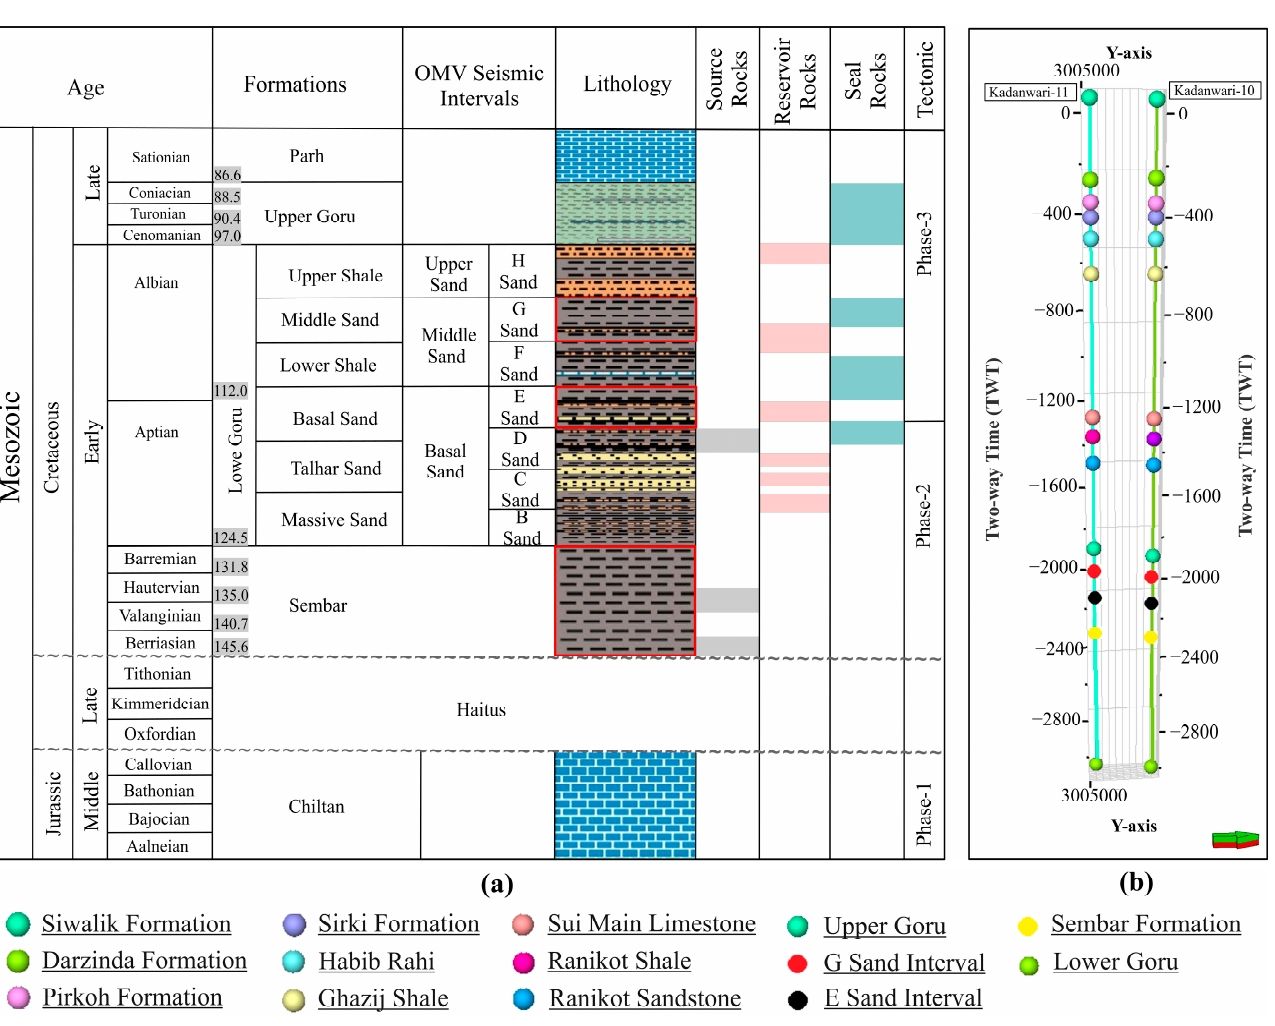
Figure 2. ( a ) Generalized stratigraphic column of the study area, modified from [48] ; ( b ) lithostratigraphic columns showing the rock units encountered in Kadanwari-10 and Kadanwari-11 wells.